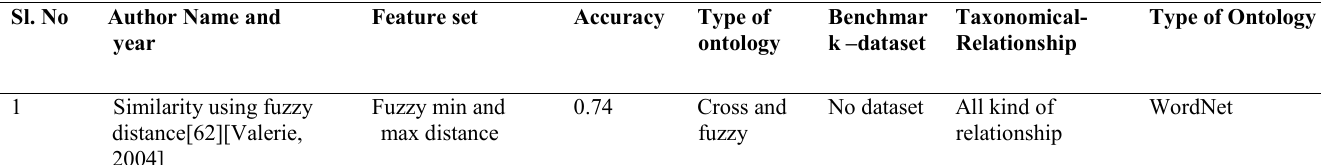
Table 5. Hybrid Measures on various